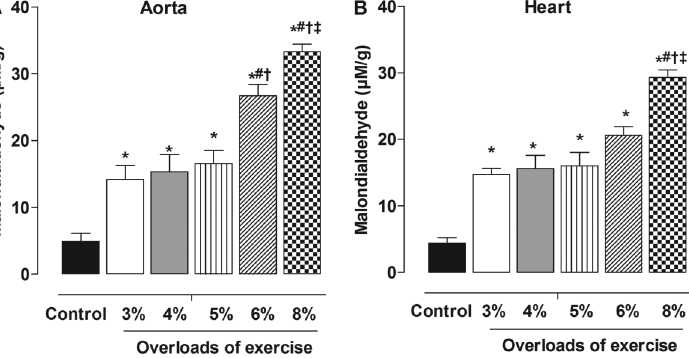
Figure 4. Levels of lipid peroxidation in aorta ( A ) and heart ( B ) in control group and groups with exercise intensity based on loading with 3, 4, 5, 6 and 8% of body weight, during swimming exercise. Data are reported as means ± SE (n=5 per group). *P o 0.05 vs control; # P o 0.05 vs 4%; + P o 0.05 vs 5%; = P o 0.05 vs 6% (one-way